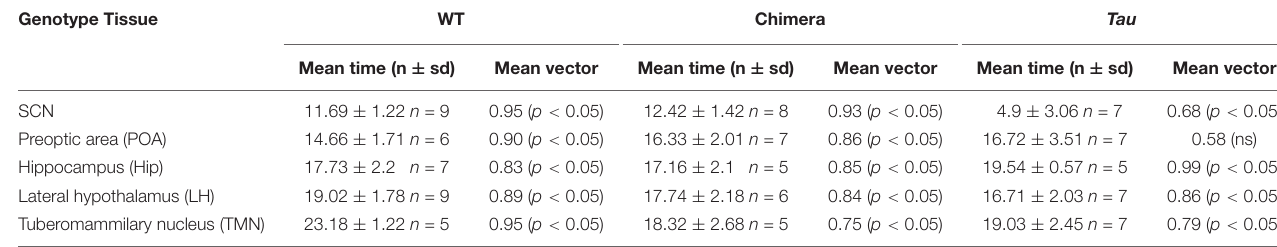
TABLE 1 | Mean circadian phase and vector of ex vivo tissues from mice (Related to Figure 2 ). Genotype Tissue